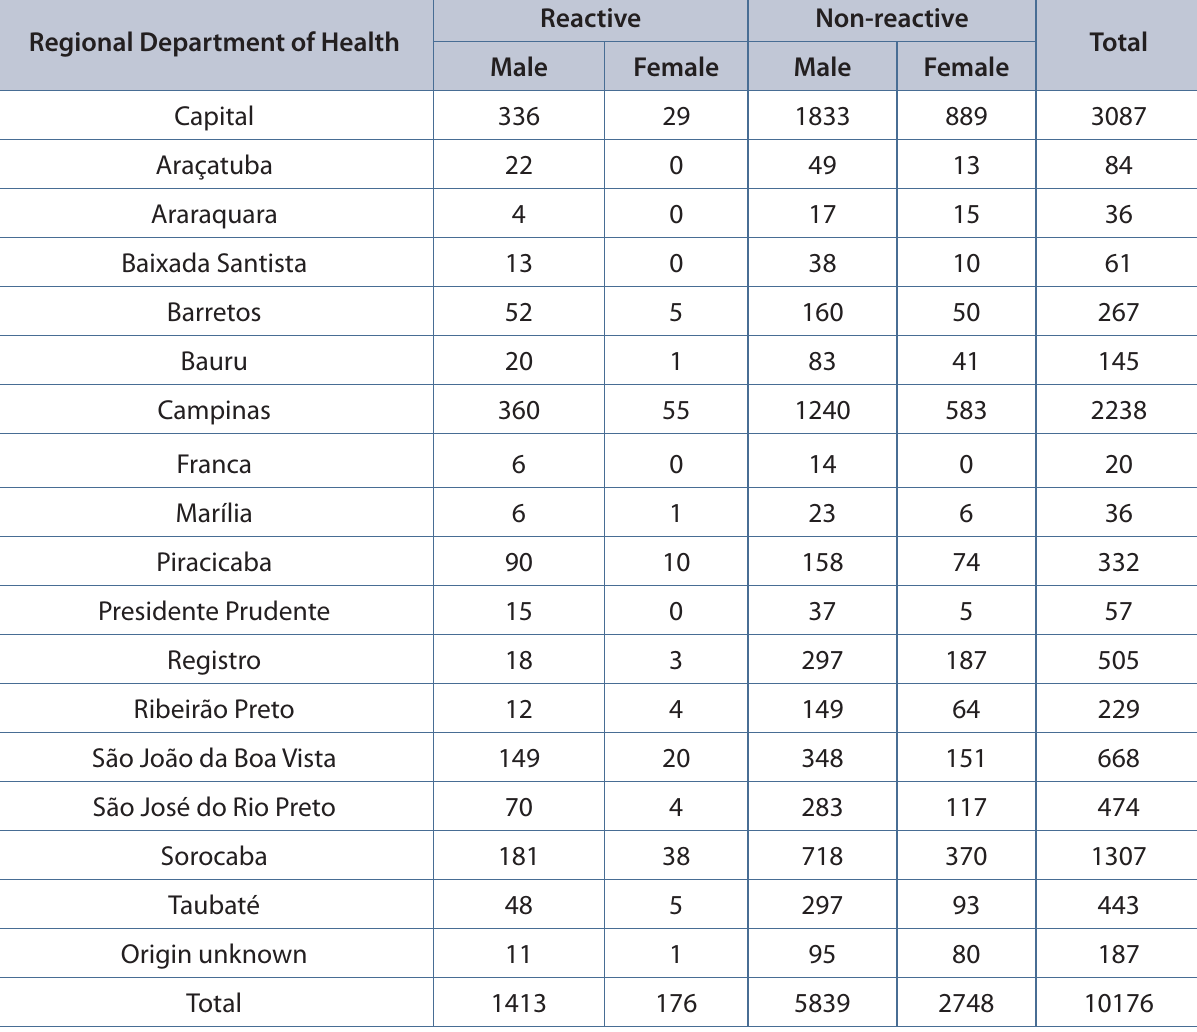
Table 1. Distribution of requests for paracoccidioidomycosis immunodiffusion assay by Regional Department of Health (DRS) from January 1999 to May